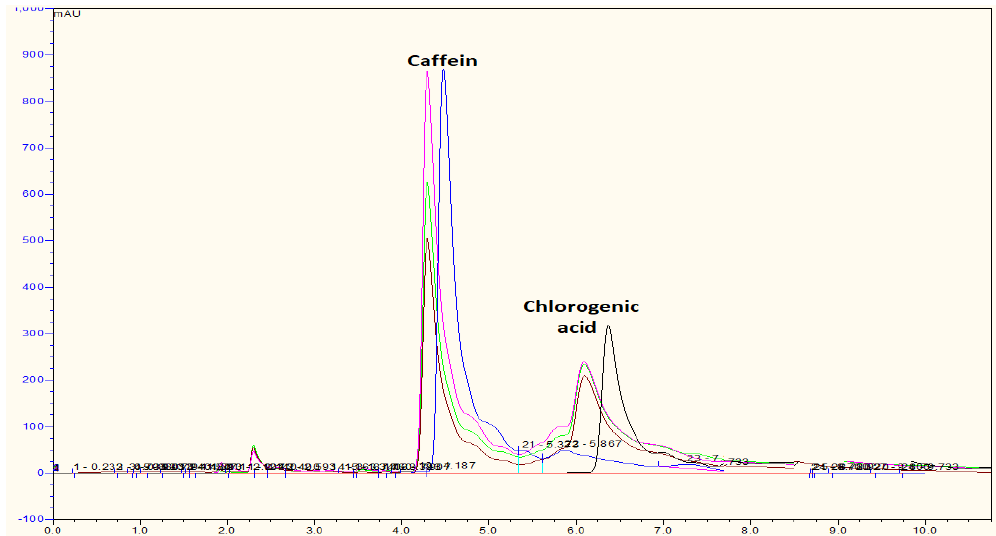
Figure 2. Chromatogram of HPLC (methanol: with acetic acid 1% (40:60) from the extract coffee bean (pink line: sample from Tasikmalaya; brown line: Pangalengan; green line: Garut; blue line: caffeine standard; black line: chlorogenic acid standard).